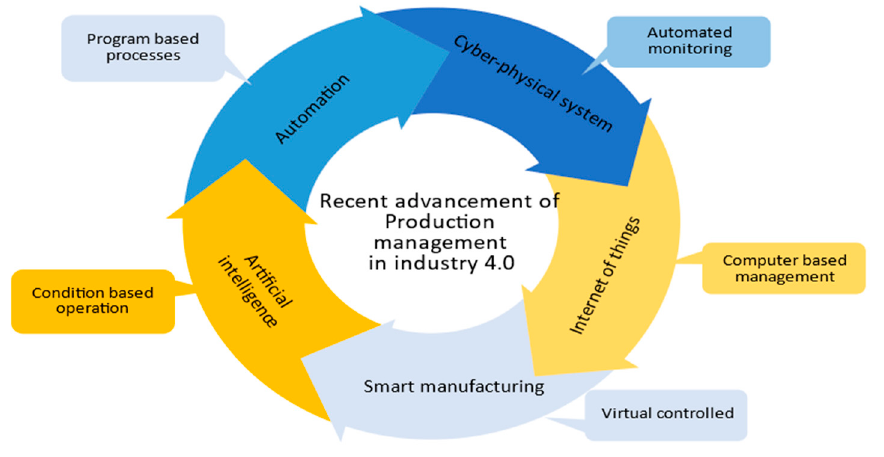
Figure 2. Recent advancements in industry 4.0.